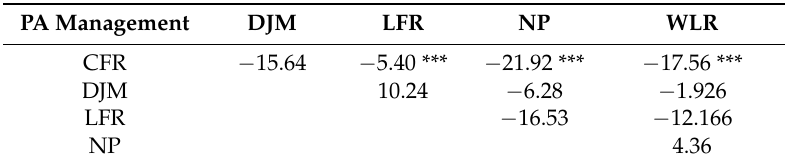
Table 2. Results of the least significance difference test (LSD) for the mean difference for pairwise comparison in the mean of carbon change (t/ha) for the period 2000–2012 between PA management categories. Comparisons significant at the 0.05 level are indicated by ***.